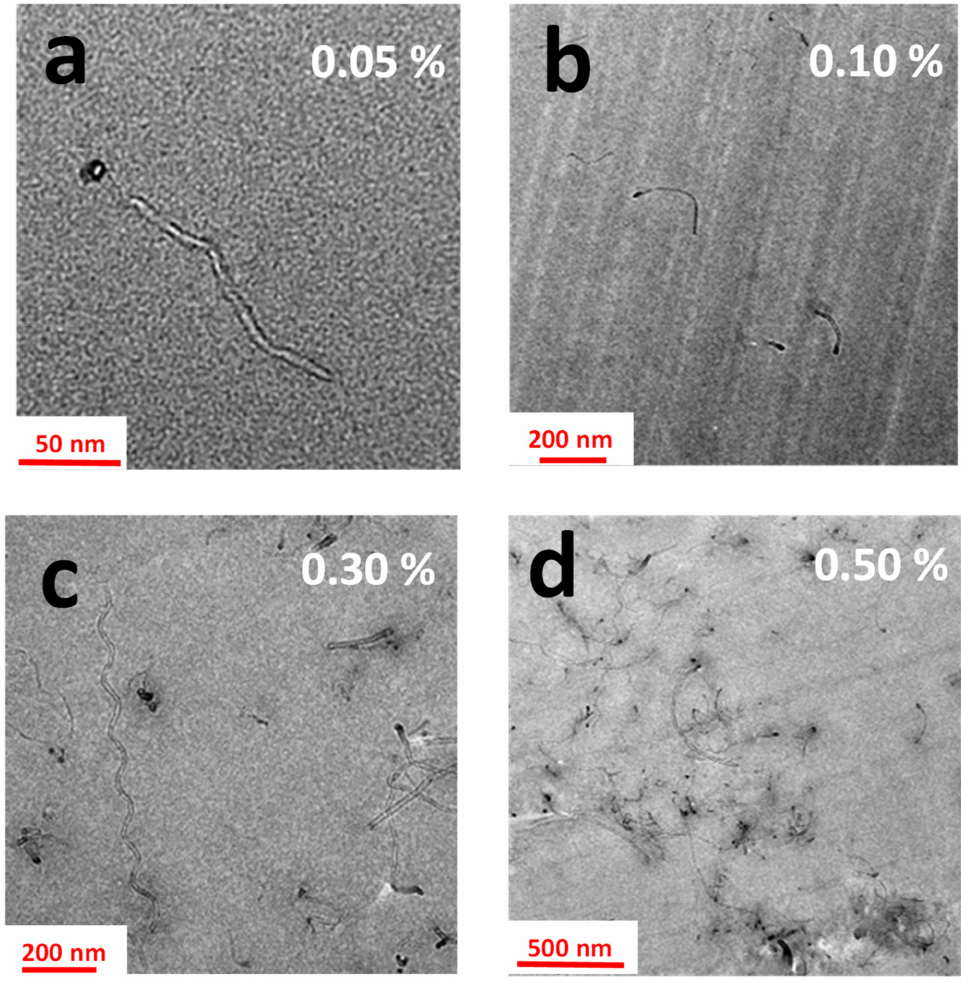
Figure 1. HRTEM images of the tetraglycidyl methylene dianiline (TGMDA) formulation containing embedded different concentrations of multi-wall carbon nanotubes (MWCNTs): ( a ) 0.05 wt.%; ( b ) 0.10 wt.%; ( c ) 0.30 wt.%; ( d ) 0.50